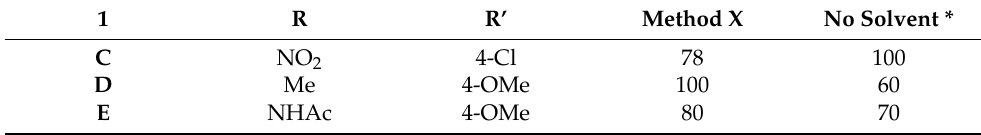
Table 1. Comparison of the yields obtained using classical and green chemistry